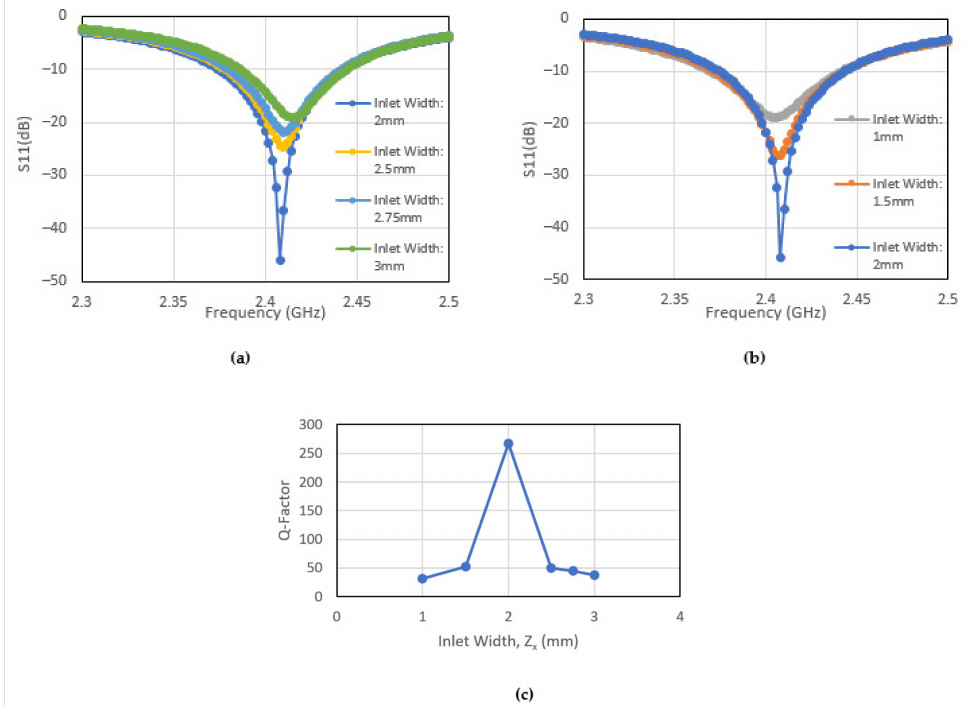
Figure 6. Resonant behavior of patch antenna as a function of changing width of recessed region, Z x ( a )—increase in Z x from 2 mm; ( b )—reduction in Z x from 2 mm; and ( c )—the Q